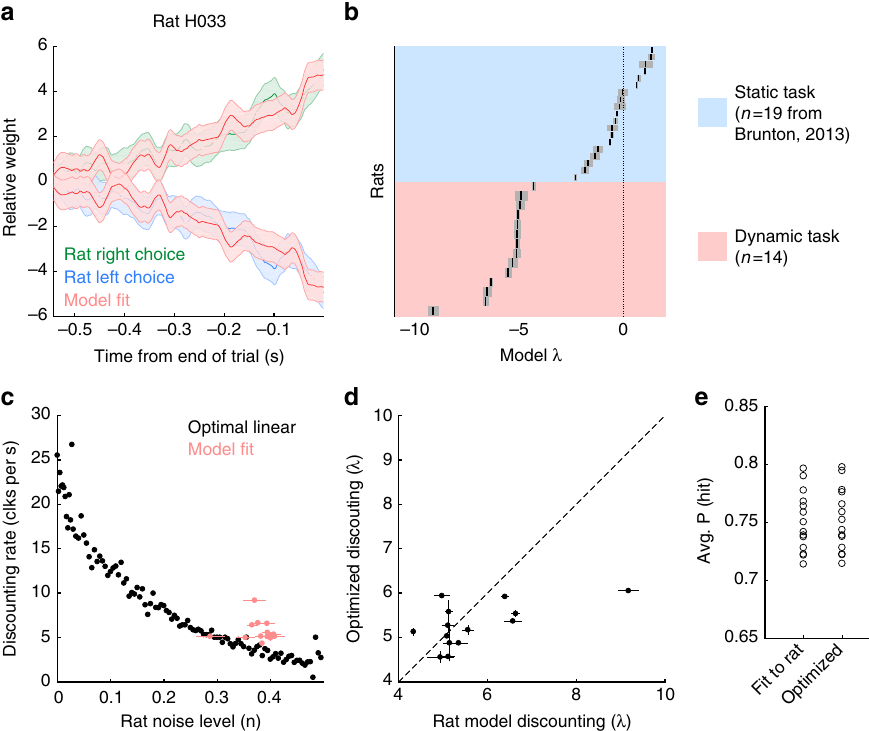
Fig. 5 Trial-by-trial model captures rat behavior, and shows optimal linear discounting. a Example reverse correlation curves generated by the trial-by-trial model (light red) compared with a rat ’ s behavior (blue and green). Shaded area is one standard deviation. b – d Error bars show 95% con fi dence intervals. b Best fi tting discounting rates for rats trained on the dynamic task (light red), and for rats trained in a static environment (blue, data and fi ts from Brunton, 2013 12 ). c Each rat ’ s noise level and discounting rate (light red) compared to the optimal linear trade-off (black). d Each rat ’ s evidence discounting parameter compared to the accuracy maximizing discounting level. e The average accuracy for the model fi t to each rat ’ s behavior, and optimized to